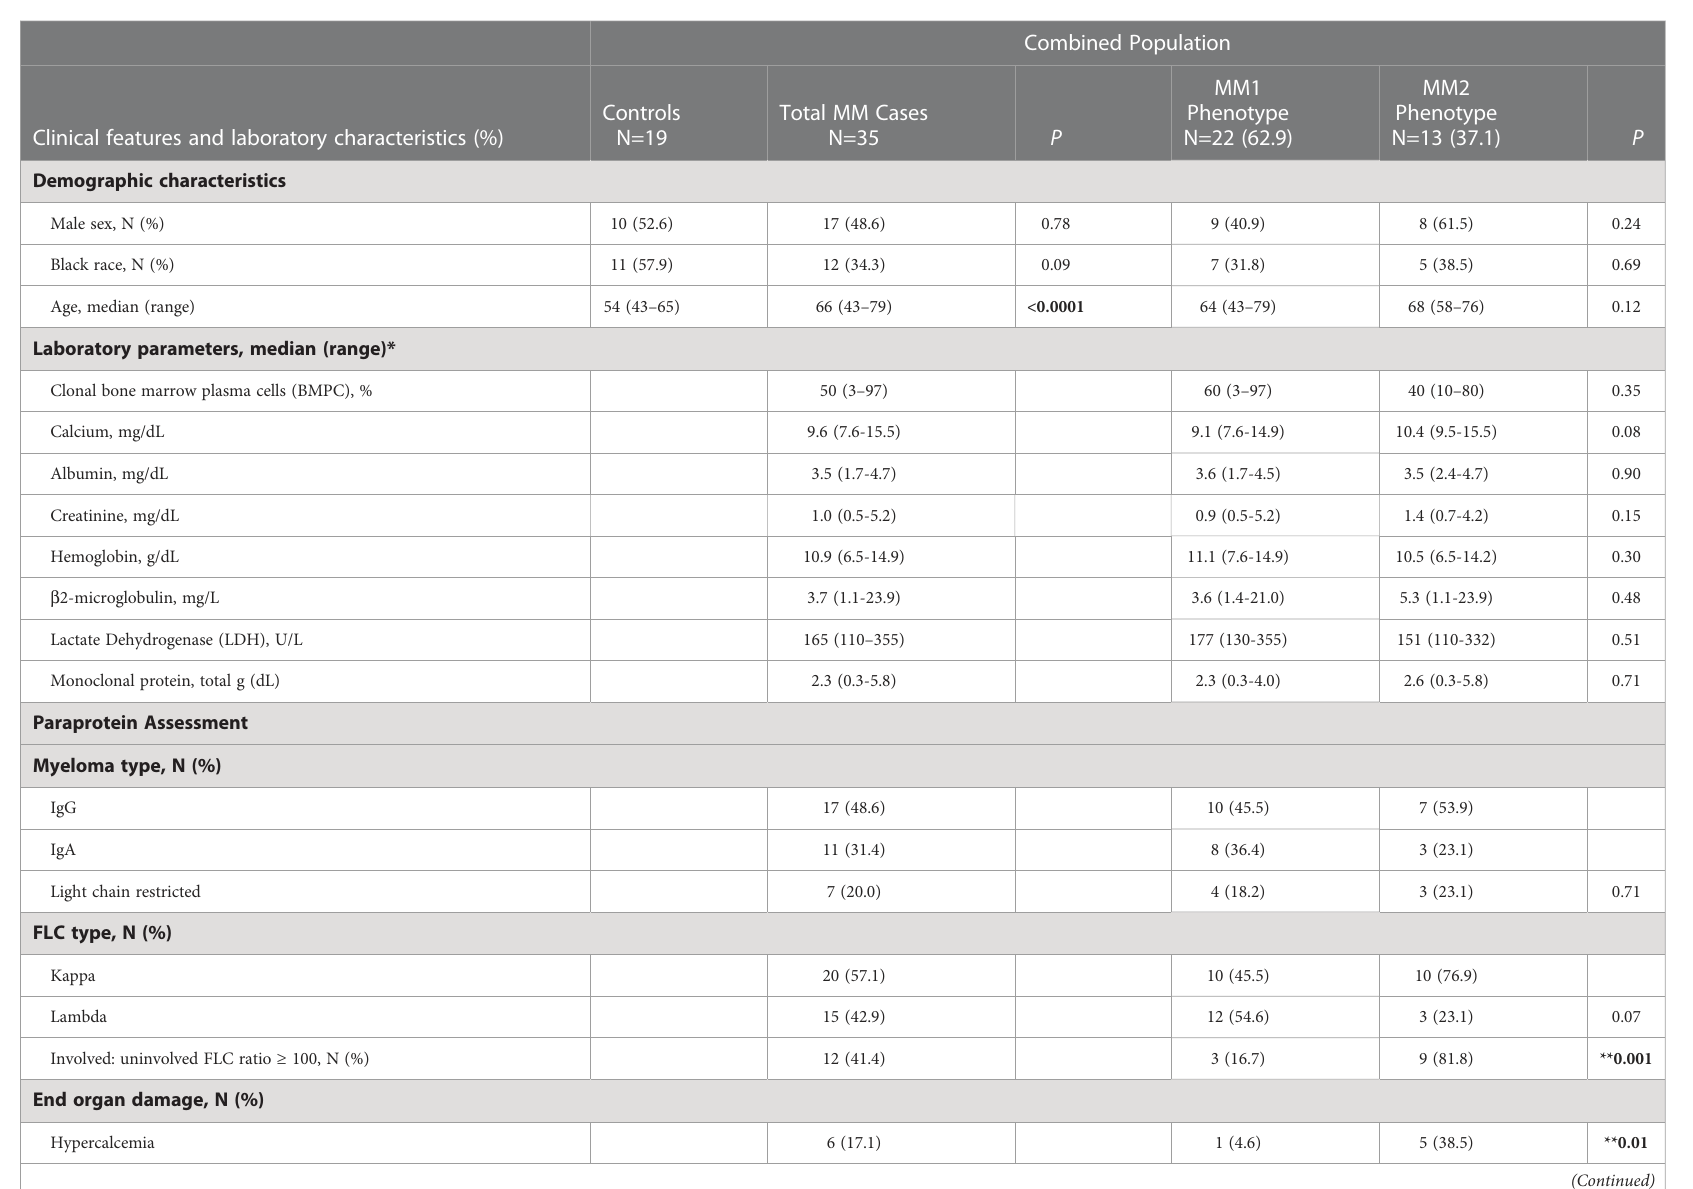
TABLE 1 Control and multiple myeloma patient demographics and diagnostic clinical and laboratory characteristics of MM patients by MM1 and MM2